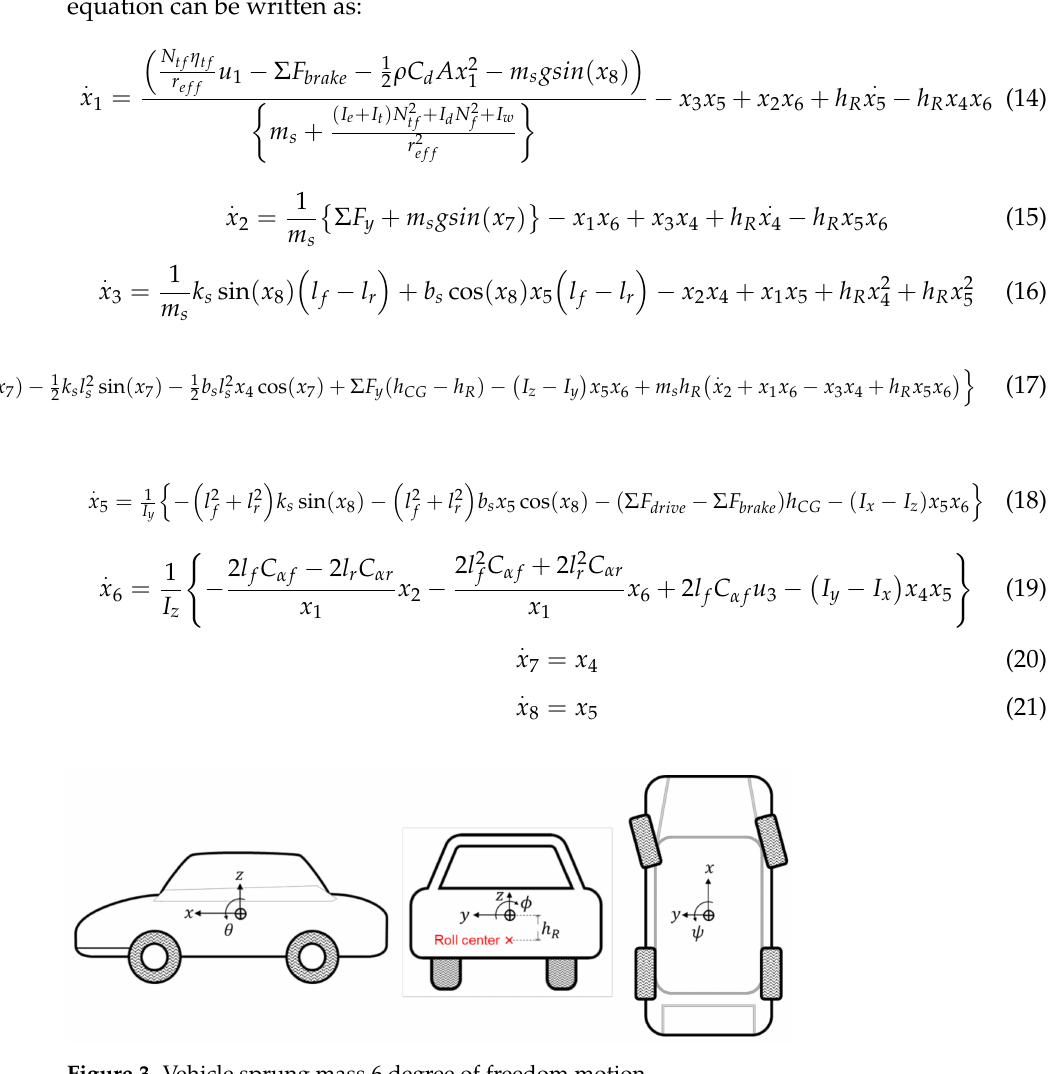
Figure 3. Vehicle sprung mass 6 degree of freedom motion. Σ F Σ F Σ F y have been described previously. The state vector drive , brake , and (cid:104) (cid:105) . . . x = v x v y v z φ θ ψ φ θ , state input u = [ T e P brake δ ] . ρ is the density of the air, C d is the drag coefficient and A is the frontal area of the